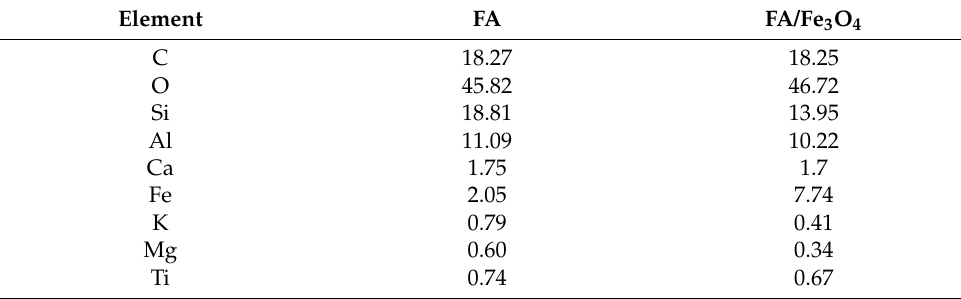
Table 2. Elemental analysis of FA and FA/Fe 3 O 4 , mass %.